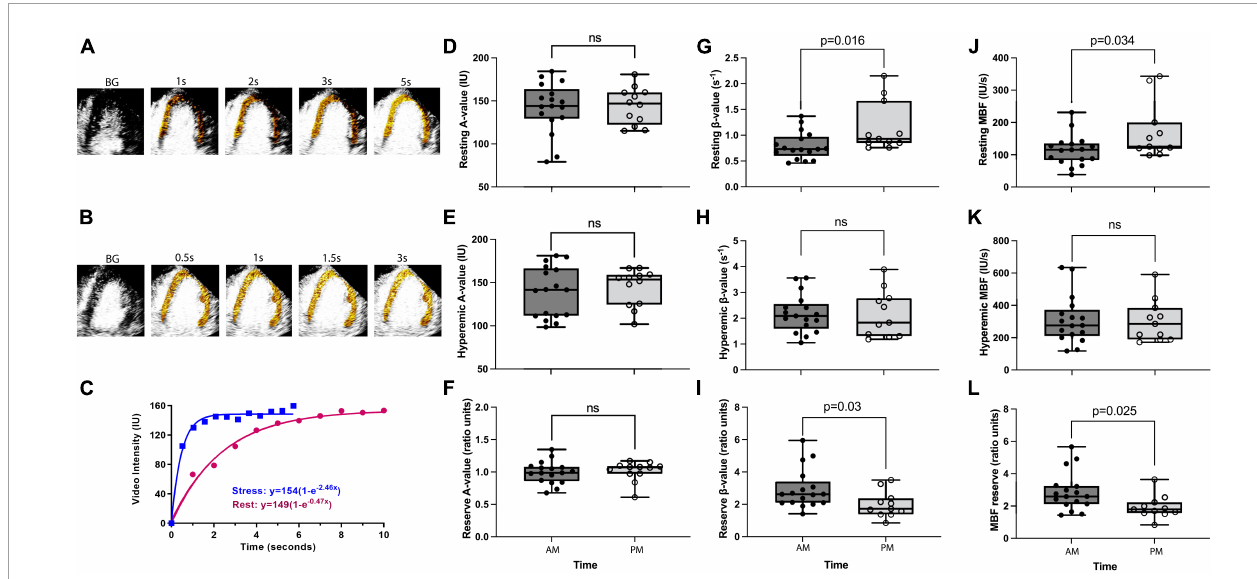
FIGURE1 Diurnal variation in coronary microvascular function. Panels (A,B) are examples of background (BG) subtracted color-coded myocardial contrast echocardiographic images from the apical four-chamber view during rest and stress, respectively, after the destructive pulse sequence illustrating replenishment. Panel (C) is an example of time-intensity data from the myocardium at rest and during regadenoson stress. During stress, the video intensity plateaus between 1 and 2 s and with a severalfold increase in the β (microvascular flux rate) value. Panels (D–F) show resting, hyperemic, and reserve A values (i.e., microvascular capillary volume), respectively. There is no difference between AM and PM groups for either of these parameters. Panels (G–I) show resting, hyperemic, and reserve β values, respectively. A significantly lower resting β value in the AM group leads to a significantly increased β reserve in the AM, whereas hyperemic β is not different between groups. Panels (J–L) show resting, hyperemic, and reserve myocardial blood flow [MBF (A × β )] values, respectively. Significantly lower resting MBF in the AM group leads to a significantly increased MBF reserve in the AM, whereas hyperemic MBF is not different between groups. P -values stated where P < 0.05, ns refers to a P -value of >